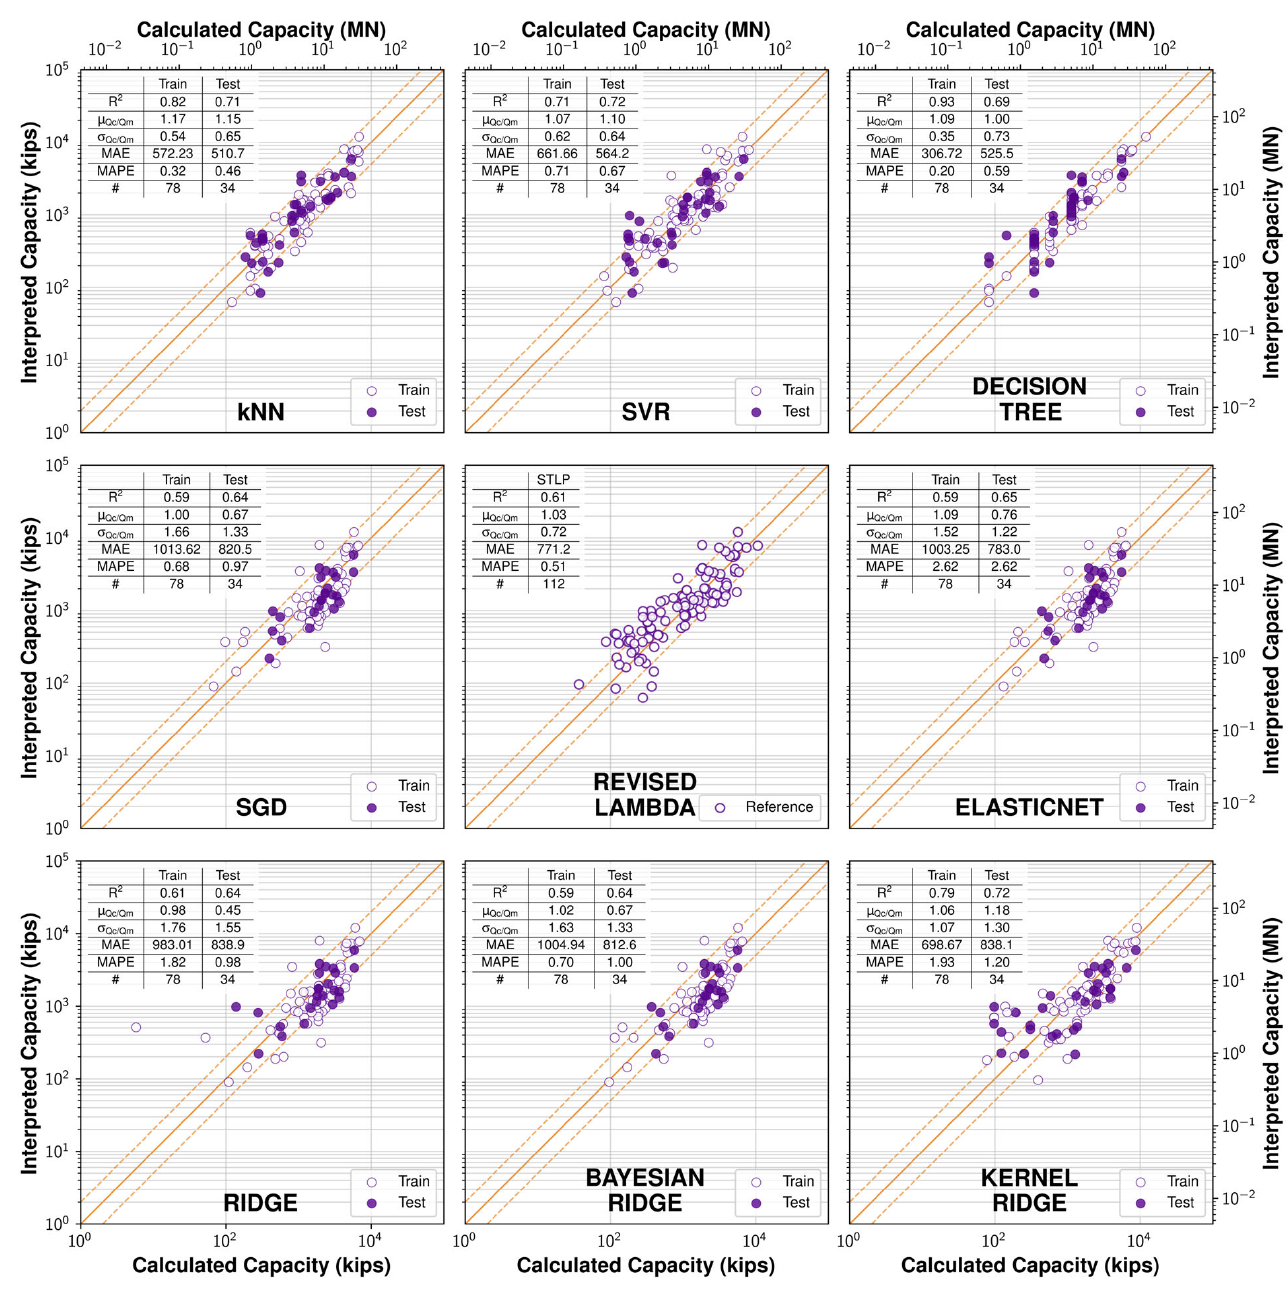
Figure 4. Performance of machine learning models. (1:1, 1:0.5, and 1:2 lines are shown in orange)